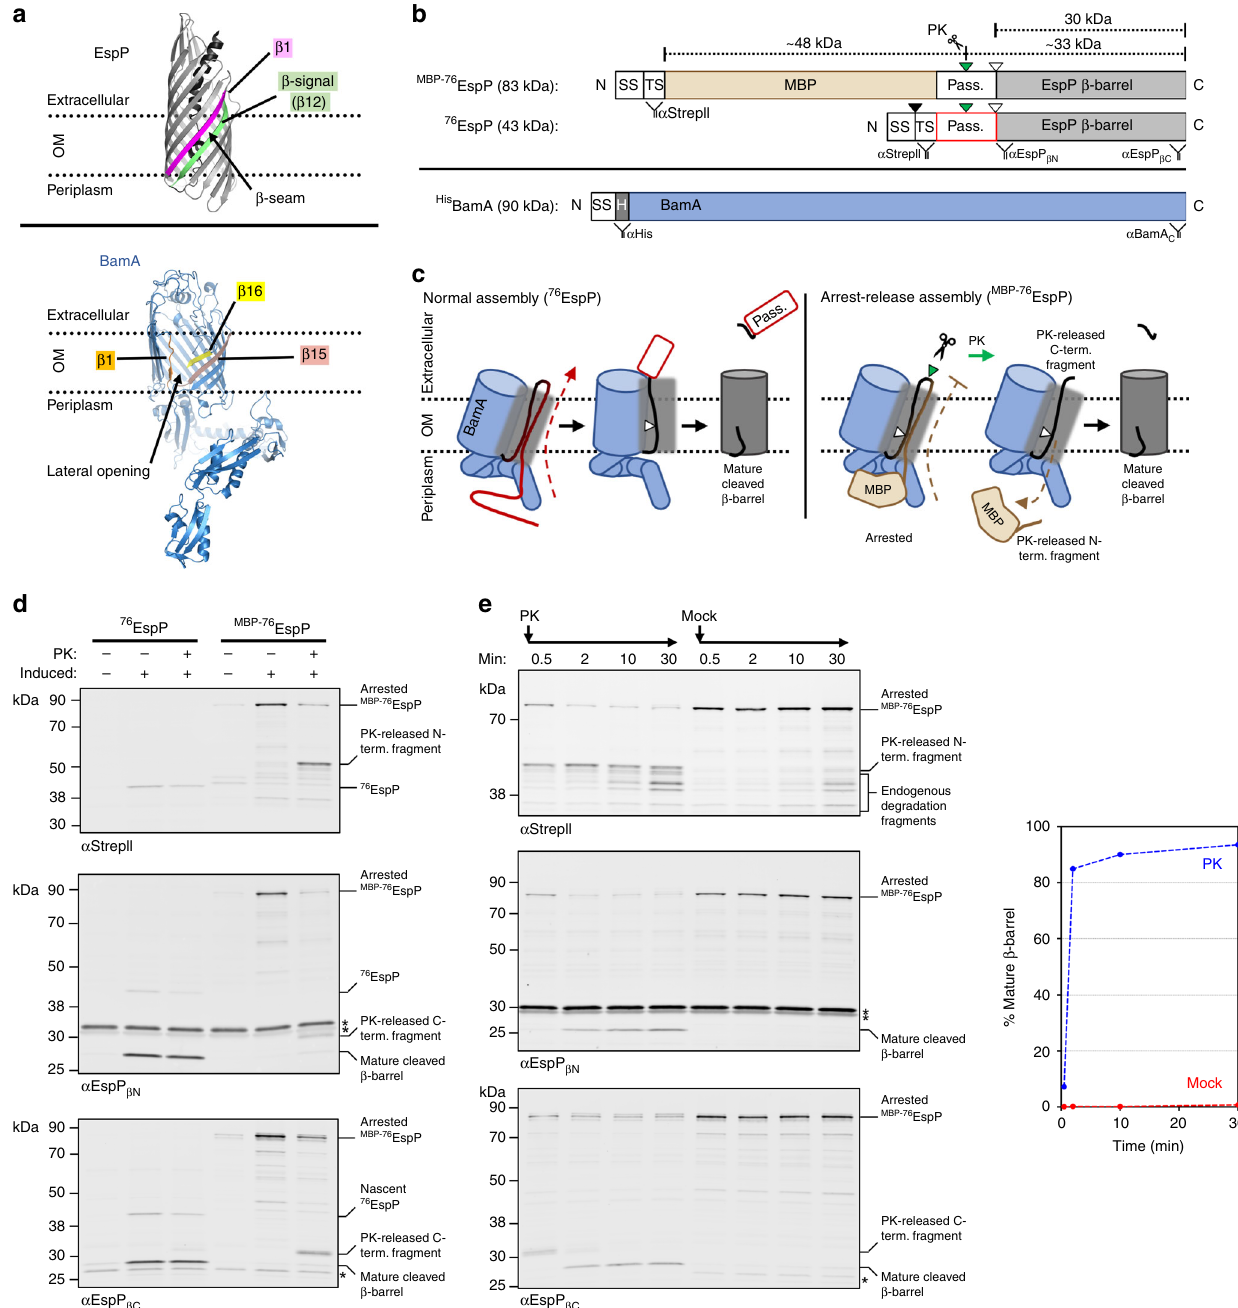
key load-bearing structure 1 that is densely packed with proteins 2 . Integral outer membrane proteins (OMPs) serve multiple critical cellular functions, including nutrient uptake 3 , protein secretion 4,5 and adhesion 6 . Almost all of these proteins are anchored to the OM by a unique ‘ β -barrel ’ structure. OMP β - barrels form closed antiparallel β -sheets held together by hydro- gen bonds between the fi rst β -strand and a conserved C-terminal β -strand (the ‘ β -signal ’ ) that create a ‘ β -seam ’ 7 – 9 (Fig. 1a, top). The result is a highly stable amphipathic structure ranging in size from 8 to 36 β -strands with alternating hydrophobic lipid-facing and hydrophilic lumen-facing residues. Some OMPs contain separately folded extracellular or periplasmic domains or seg- ments that are embedded inside the β -barrel 10 . Proteins that have